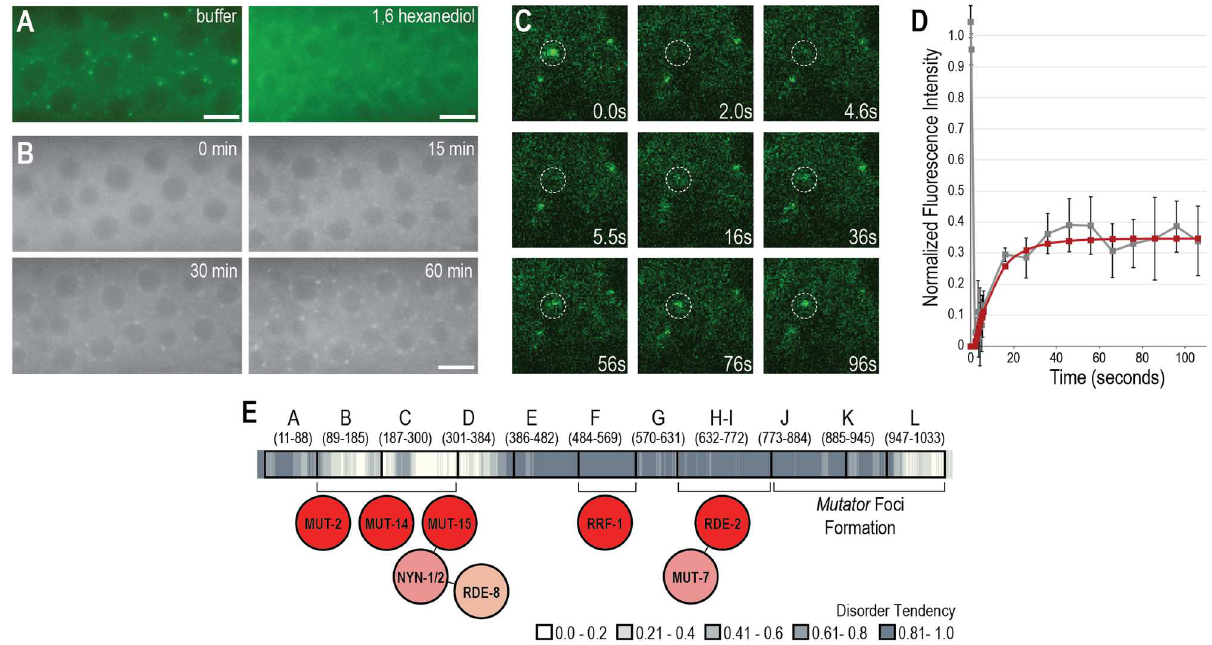
Fig 7. Mutator foci have liquid-like properties. (A) MUT-16::GFP are present in buffer control, but disappear in 5% 1,6-hexanediol. Scale bar, 5 μ m. (B) Images were collected at the indicated time points after MUT-16::GFP animals were heat-shocked for 6 hours at 30˚C and then returned to room temperature (~21˚C). MUT-16 foci are absent at the first time point (0 min), but begin to reform after ~15 min and look similar to untreated MUT-16 foci by 30–60 min. Scale bar, 5 μ m. (C) Time-lapse images show fluorescence recovery of MUT-16::GFP after a single Mutator focus is photobleached at 2.0 sec. (D) FRAP recovery curves for MUT-16::GFP. Raw data (gray line) is reported as a mean +/- SD (n = 5 granules). Data was fitted to a single exponential recovery curve (red line). (E) Schematic of MUT-16, indicating regions required for interaction with other Mutator complex proteins and for Mutator foci formation. Shading along the length of the MUT-16 protein represents disorder tendency calculated using IUPred (see Fig 1A).